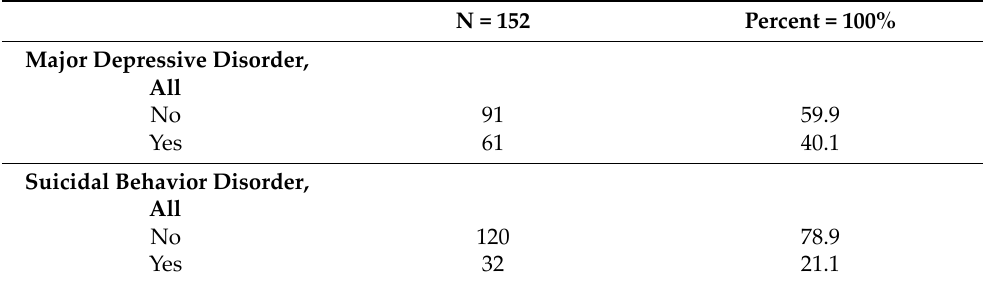
Table 2. Prevalence of specific mental disorders among the LGBT+ community in